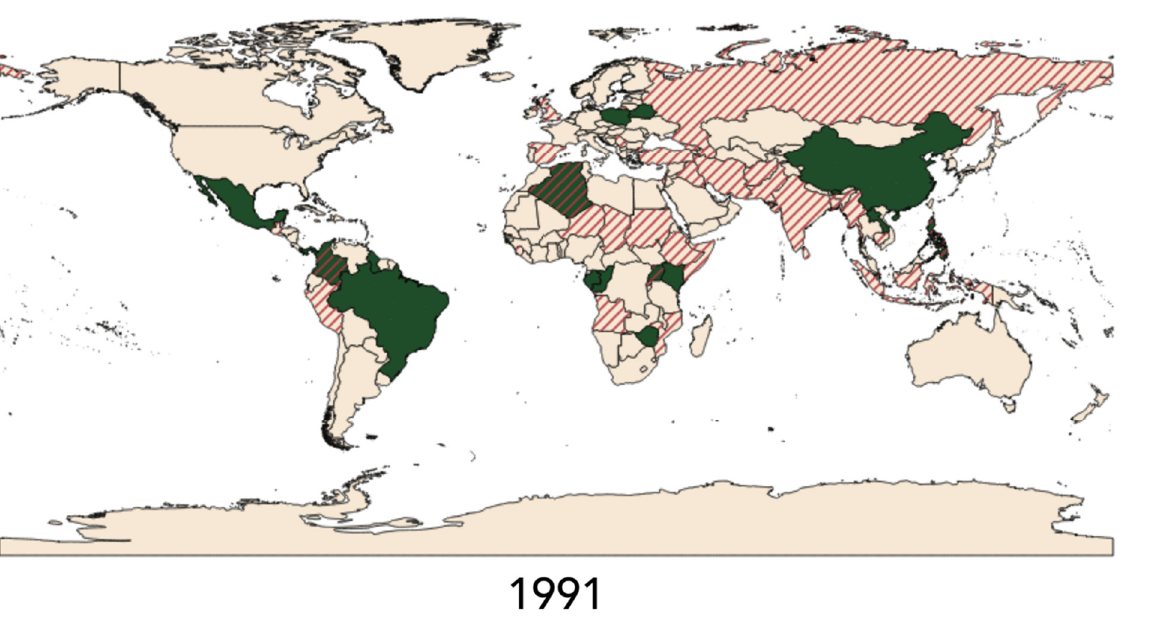
Figure 2. Overlay maps-GEF recipients with single country projects and active conflict (animated gif). GEF recipient country (solid dark green). Country experiencing active armed combat (red diagonal).